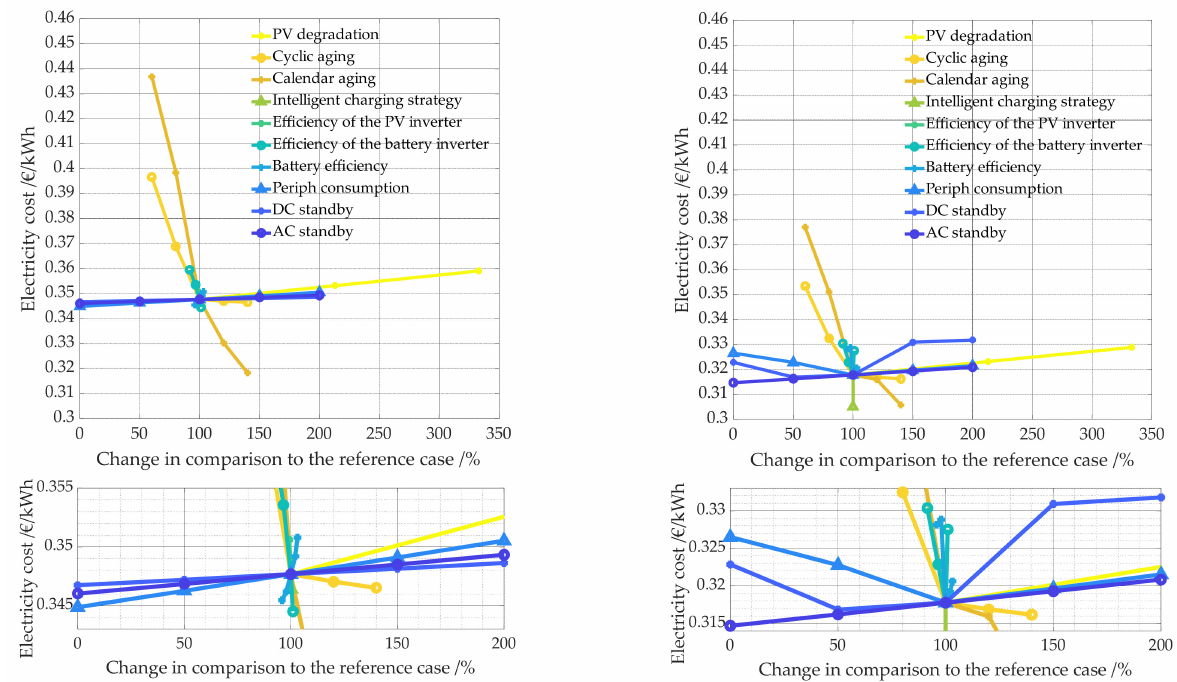
Figure 29. Impact on electricity costs due to the change in technical parameters. The left panel shows the PV system battery combination of 15 kWp and 10 kWh, the right one of 15 kWp and 5 kWh. While the upper figures show all data points, the lower figures show only parts of the data in order to better illustrate even small changes in relation to the reference case.